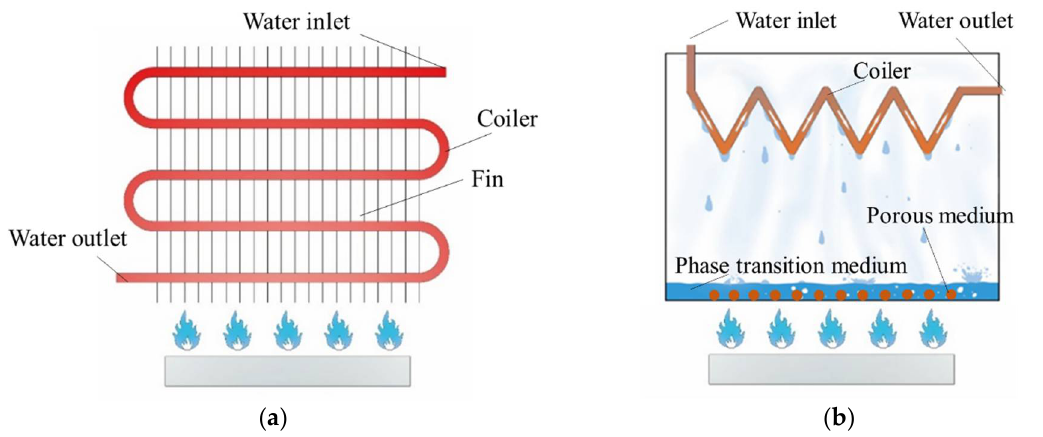
Figure 1. ( a ) Working principle of the existing heat exchanger in gas water heater; and, ( b ) Phase transition in the new heat exchanger in gas water heater.